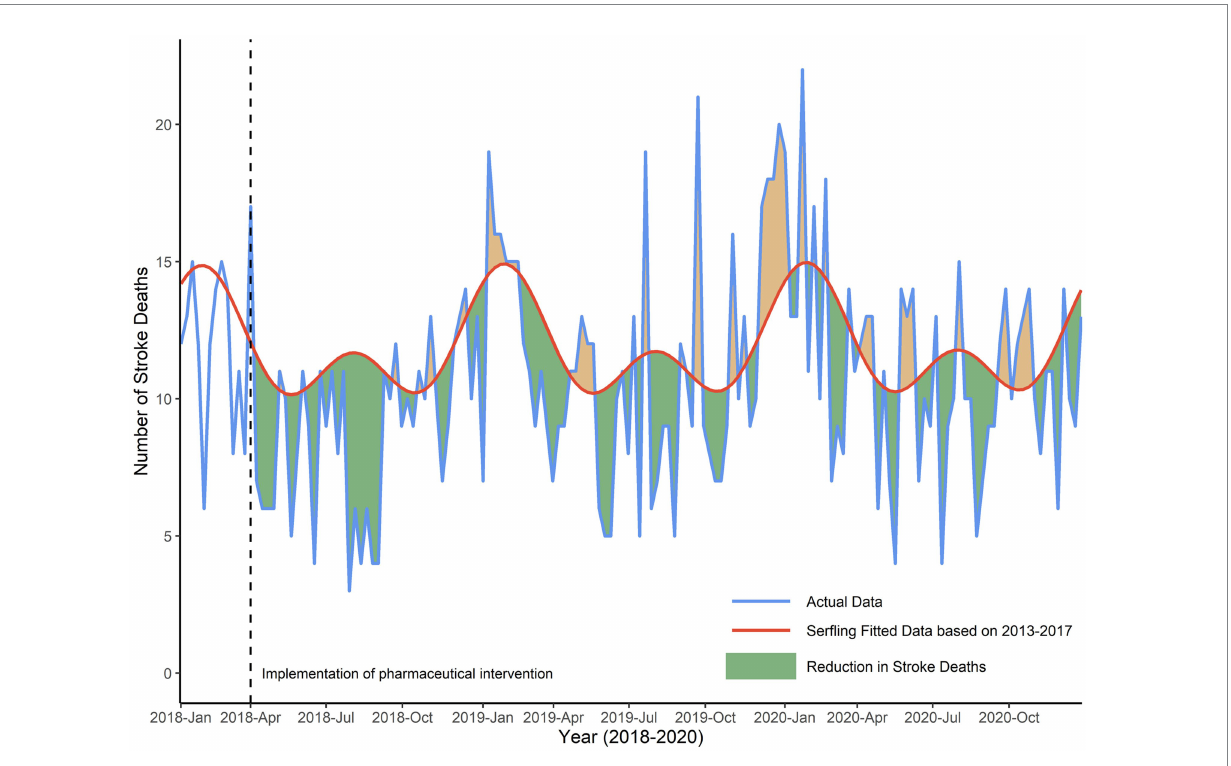
FIGURE 2 Reduction in number of weekly stroke deaths in Deqing, 2018–2020. Green shadows were presented as the reduction in actual stroke deaths compared with predicted numbers from 2018 to 2020, due to the presence of both pharmaceutical and non-pharmaceutical interventions. Orange shadows were presented as the increase in actual stroke deaths compared with predicted